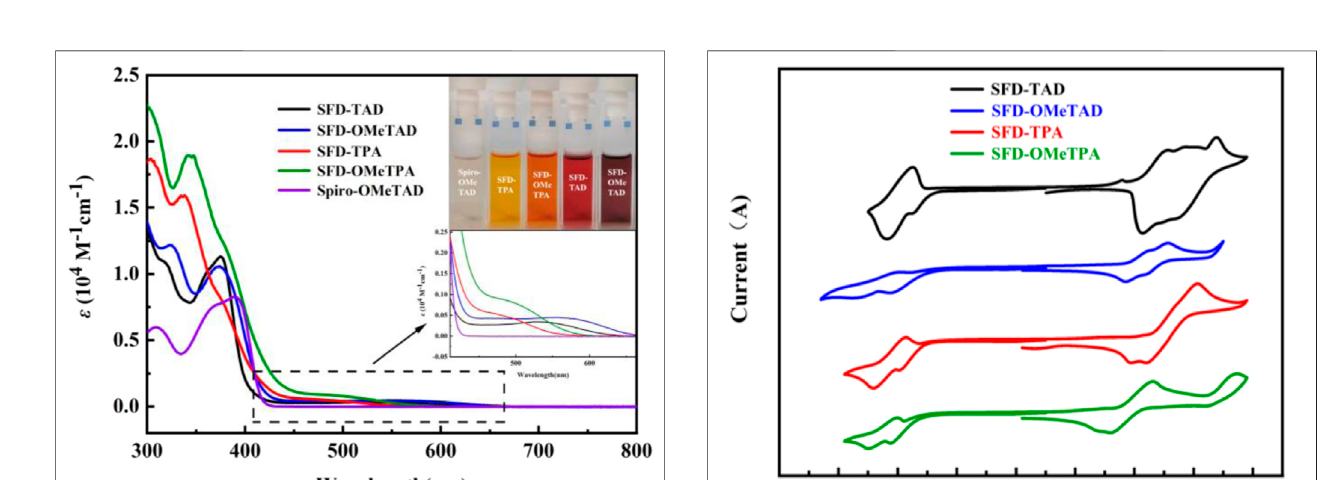
SCHEME 1 | Synthesis route of spiro-OMeTAD derivates.